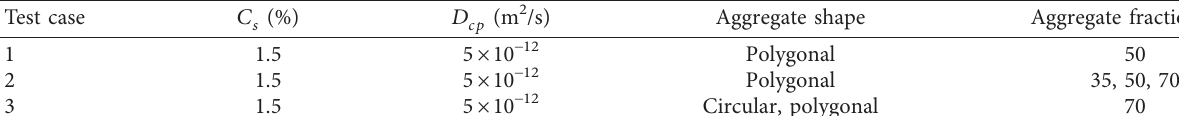
Table 1: Numerical design for aggregate analysis.